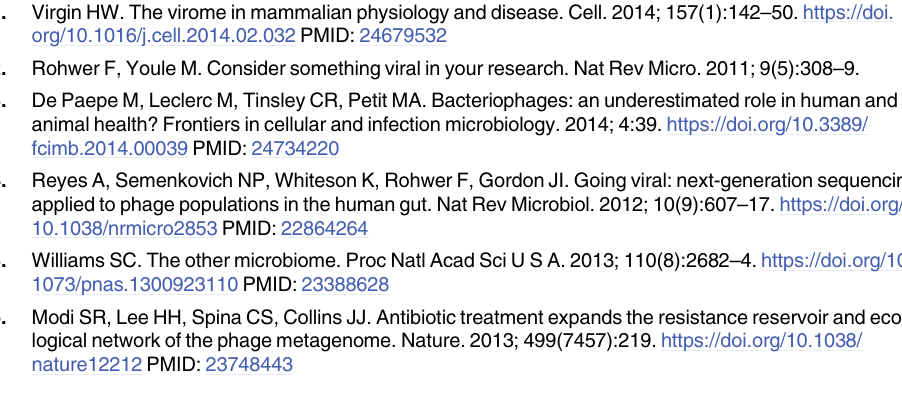
S2 Table. S2 Table shows the hits for all crAssphage reference proteins across the samples. (XLSX) S1 Fig. Relative abundance of genus Bacteroides among Matses individuals. Boxplot denot- ing percentage relative abundance of Bacteroides sp. among Matses individuals. Values corre- sponding to crAss-positive individuals are denoted in red. S2 Fig. Multi-gene phylogenetic analysis of 233 crAssphage strains. The Maximum Likeli- hood tree was based on the multi-gene alignment comprising 12,642 nucleotide sites. Sites with missing data were eliminated. The tree was built using the Generalized Time-Reversible model with gamma-distributed rate variation and proportion of invariant sites. Bootstrap sup- port values estimated from 100 replicates are given; only values greater than 50% are shown. Strains are color-coded according to the geographic location: dark green–The Americas, light green–Asia, light violet–Europe, and dark purple–Middle East (Israel). The differentially-col- ored symbols next to the taxa names are used to denote strains from the same individual. (PDF) S3 Fig. Bayesian Skyline Plot of crAssphage strains. The X-axis denotes time in years before present (YBP) and Y-axis denotes estimated effective population size. The blue shaded region denotes the 95% Highest Posterior Density interval.